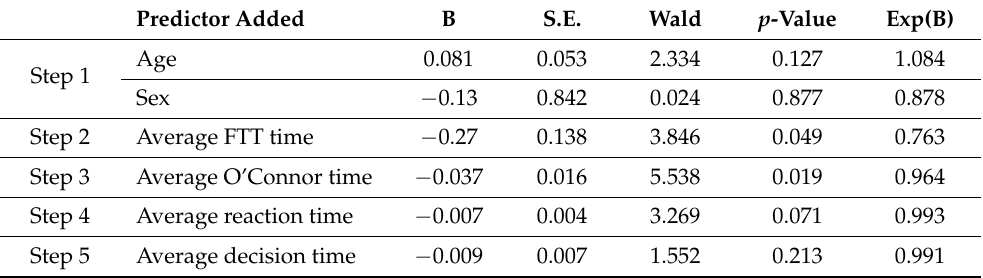
Table 5. Hypothesis ‐ driven hierarchical binary regression model for differentiation between pwMS Table 5. Hypothesis-driven hierarchical binary regression model for differentiation between pwMS and HCs. and